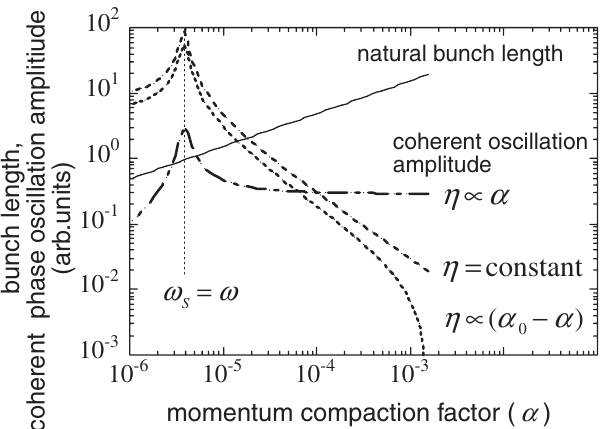
FIG. 5. Dependence of coherent phase oscillation amplitude on momentum compaction factor ( (cid:1) ). The natural dependence of the bunch length is shown as a solid line. The other lines present the coherent oscillation amplitudes due to a dipole field error at three locations. The amplitudes are set to show the (cid:1) dependence